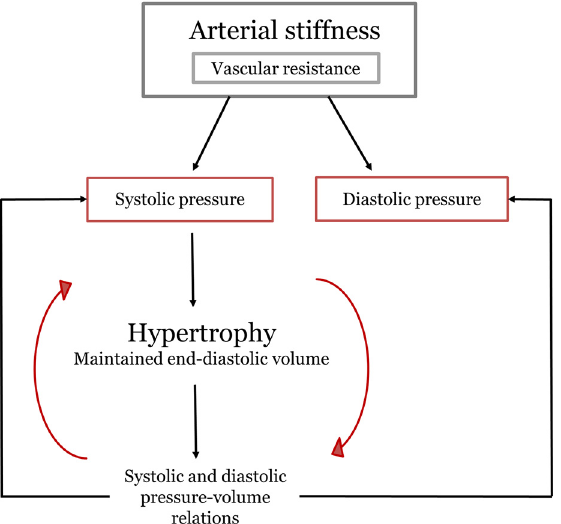
Fig 2. Scheme of the events occurring during normal aging, used to guide the model ’ s parameters selection. The loop Hypertrophy – Pressure-volume relations – Systolic pressure is repeatedly carried out until stable pressures and volumes are